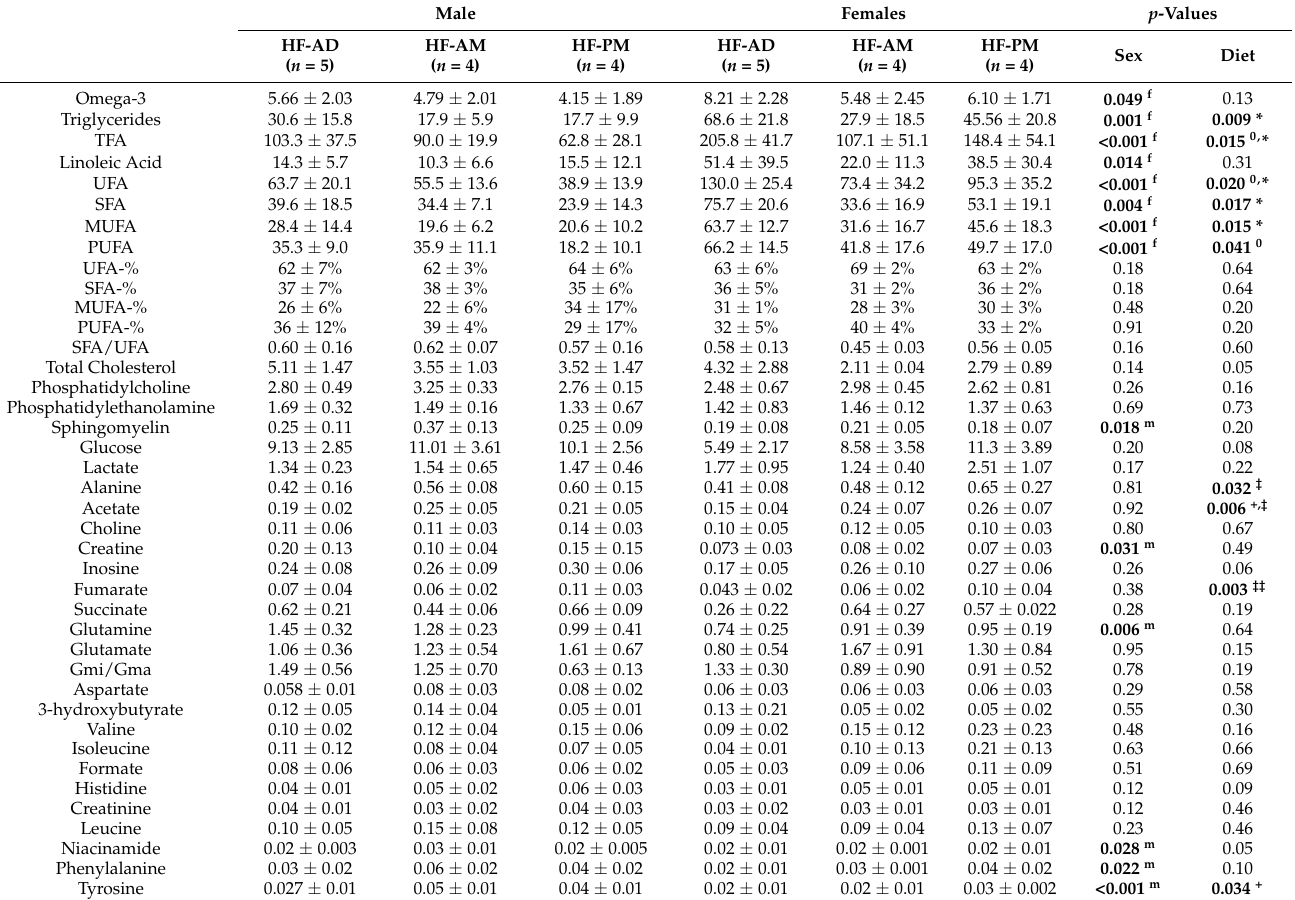
Table 3. Hepatic metabolite concentrations (mM) indicated as mean ± standard deviation for both male and female high-fat ad libitum (HF-AD), high-fat morning time-restricted (HF-AM), and high-fat evening time-restricted (HF-PM) groups. Male Females p